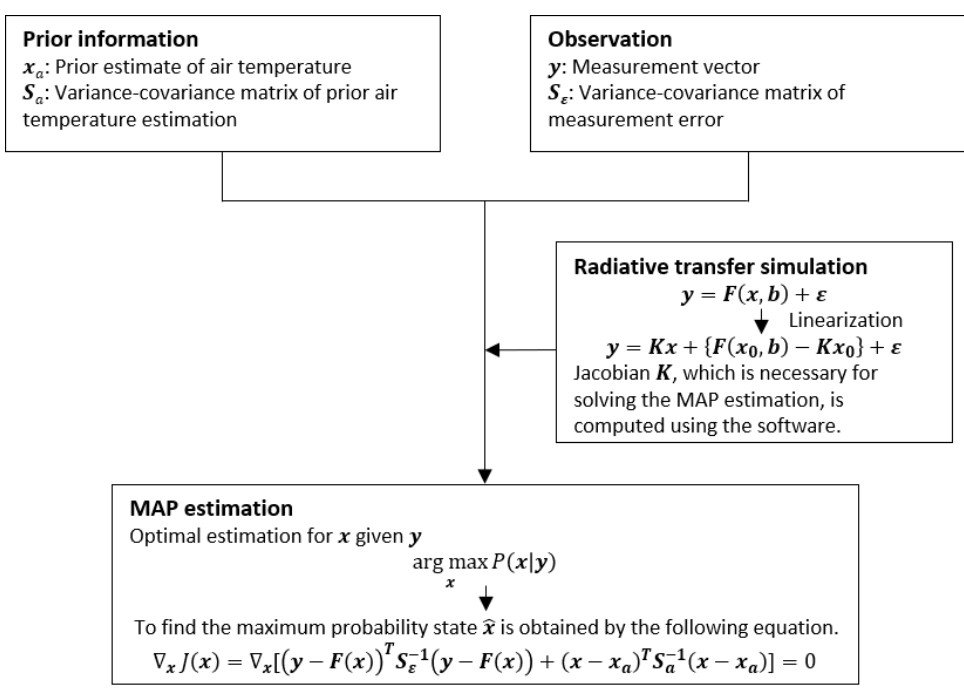
Figure 1. Flow of the inverse estimation of the air temperature